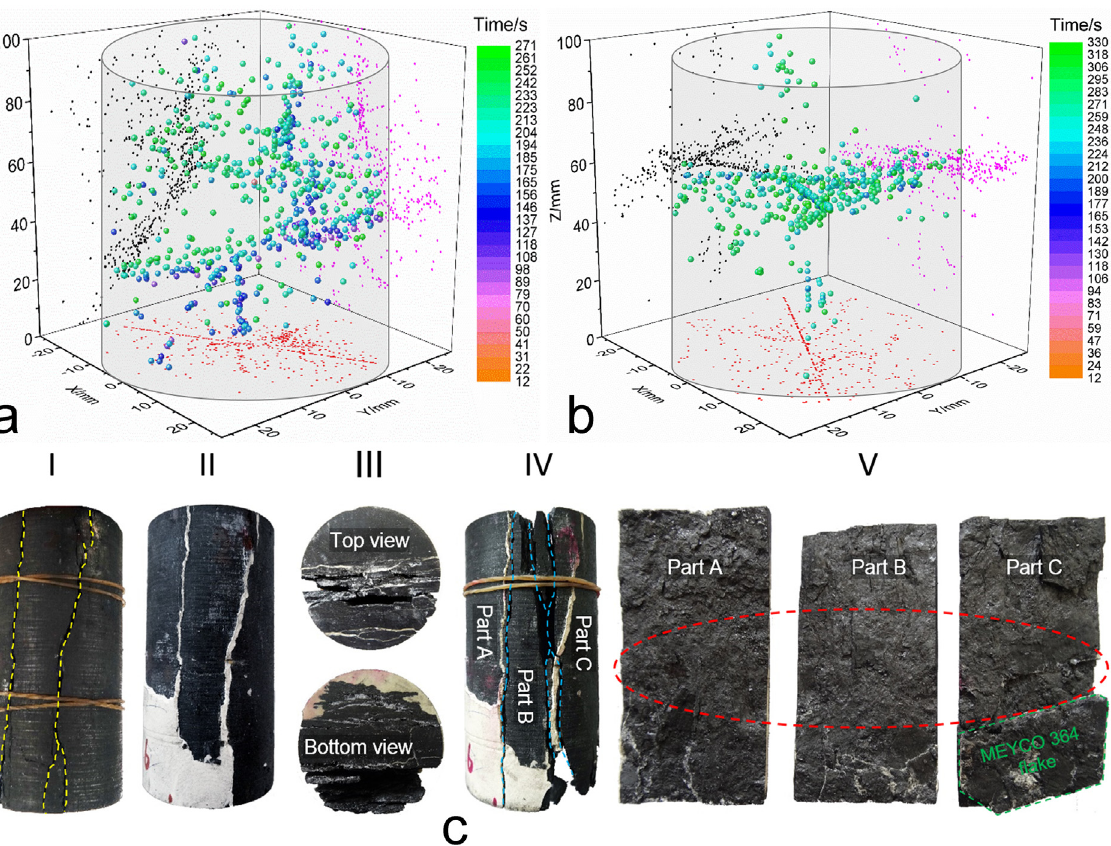
Fig 9. Locations of events that were captured by an AE test. (a) Coal No. 2 during the first round test, with a total of 751 events, where 54 events occurred during 0 – 140 s, 473 events during 140 – 250 s, and 224 events during 250 – 314 s. (b) Coal No. 2 during the second round test, with a total of 487 events, where 4 events occurred during 0 – 130 s, 83 events during 130 – 240 s, and 400 events during 240 – 330 s. (c) Fracture modes of the intact coal and restored coal. I, Fracture mode of the intact coal. II, Front view of the restored coal. III, End view for the fracture modes of the restored coal. IV, Front view for the fracture mode of the restored coal. V, Stripped parts from the fractured restored coal, where the red ellipse indicates the damage source concentration